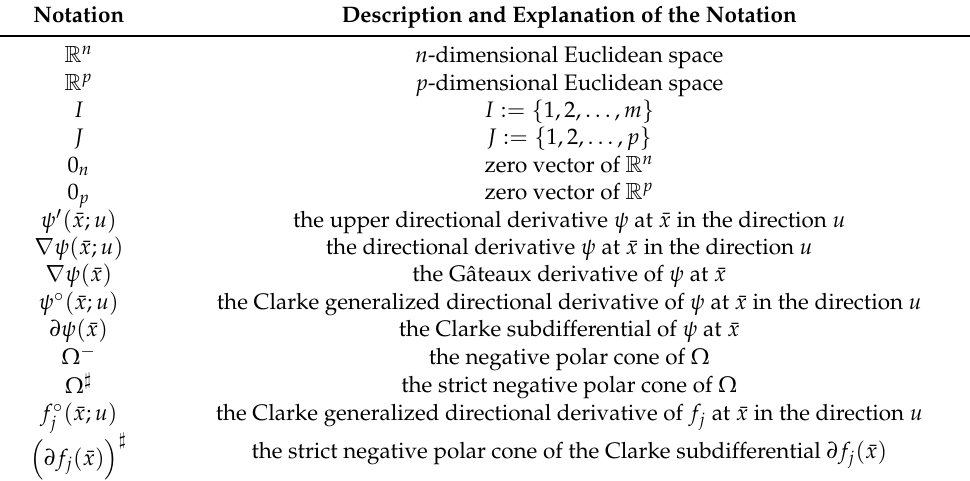
Table 1. The notations and their explanations throughout the